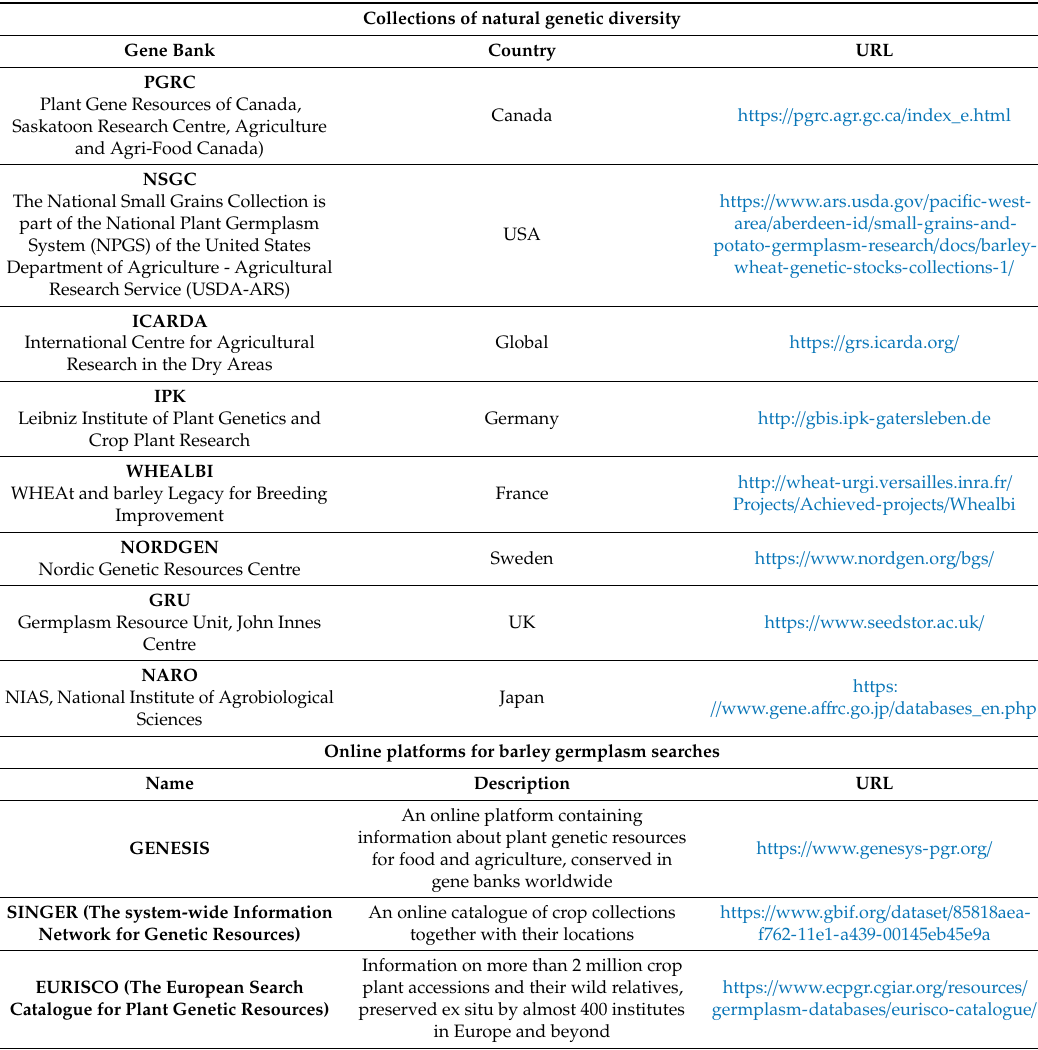
Table 2. List of representative collections of natural variants of barley available at di ff erent institutions worldwide, together with online platforms that provide information about barley genetic